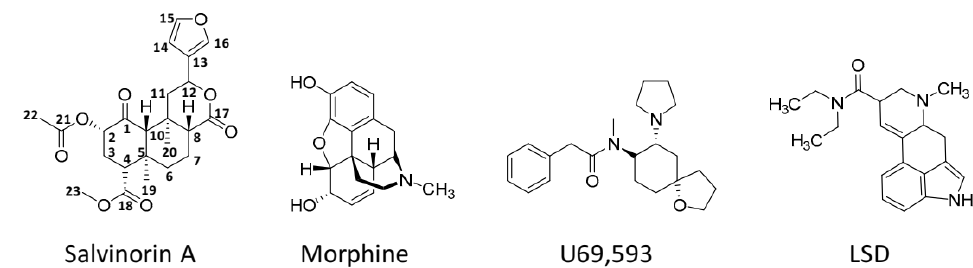
Figure 2. Chemical structures of salvinorin A, morphine (a well-known opioid), U69,593 (a potent and selective synthetic κ -opioid receptor agonist), and lysergic acid diethylamide (LSD, a recognised